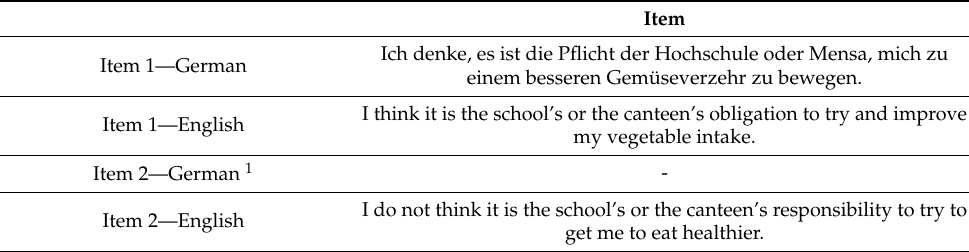
Table A3. German and English items measuring responsibility